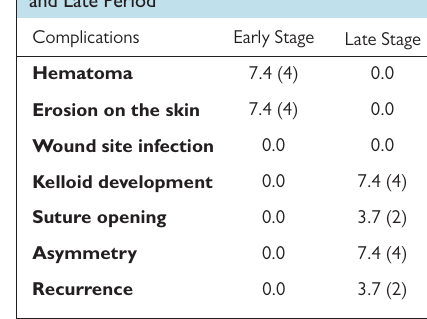
Table 2. Complication of Otoplasty in Early and Late